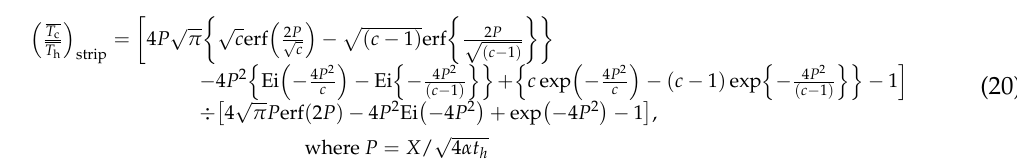
Figure 5. Temperature-decreasing ratio of the point heat source immediately after the end of heating. The temperature-decreasing ratio for the THS method in which the strip heat source is used can be as described below: